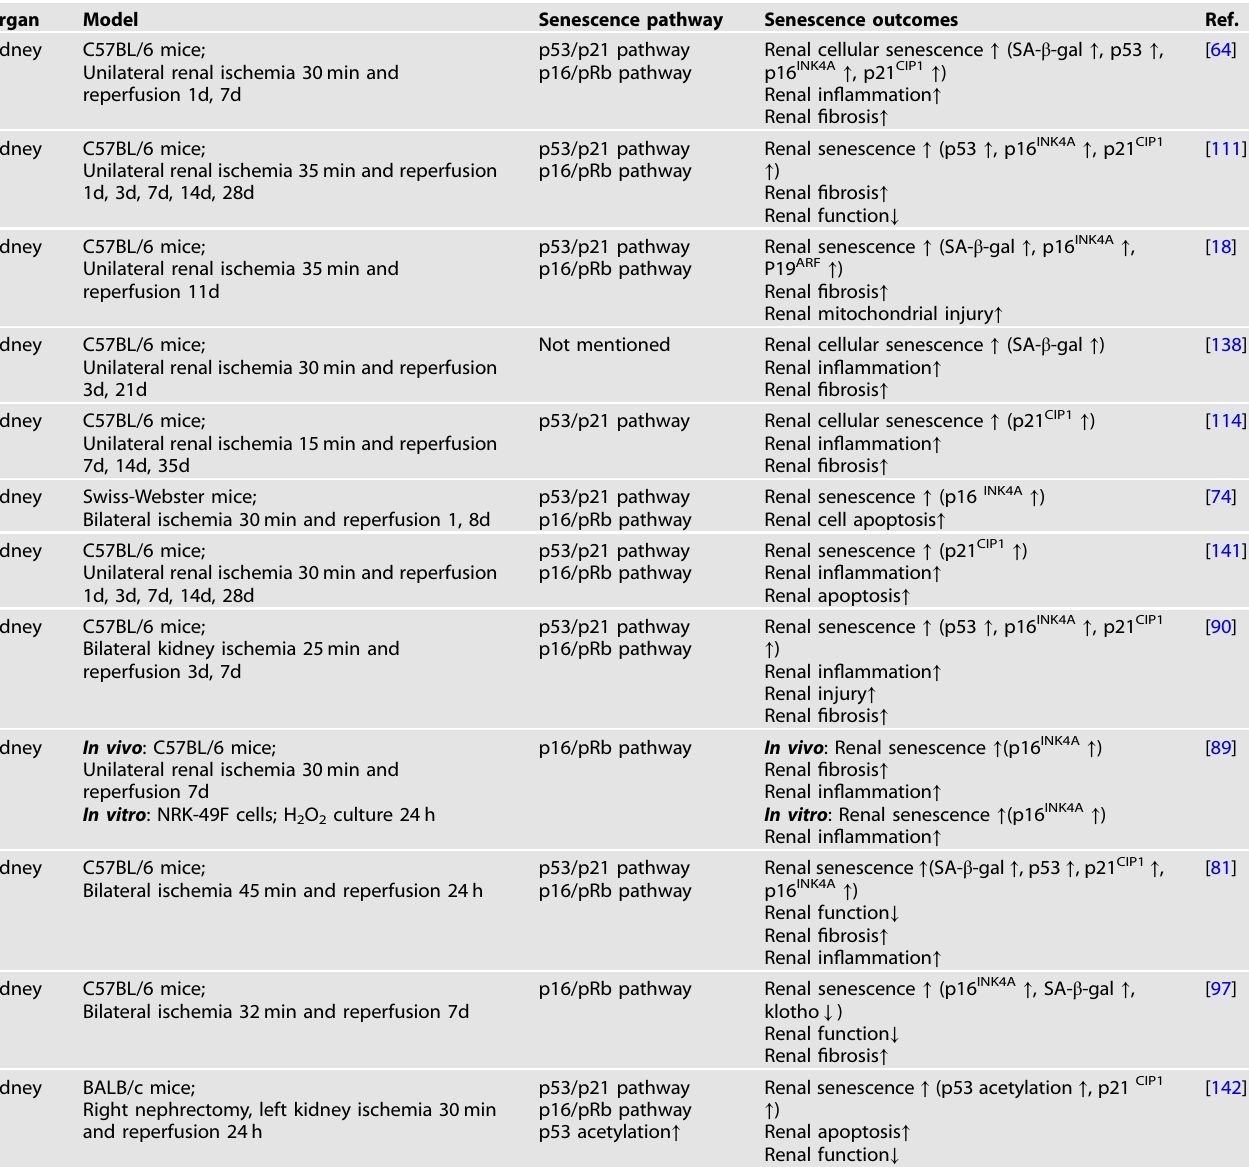
Table 1. Senescent pathways and outcomes in renal ischemia/reperfusion injury. Organ Model Senescence pathway Senescence outcomes